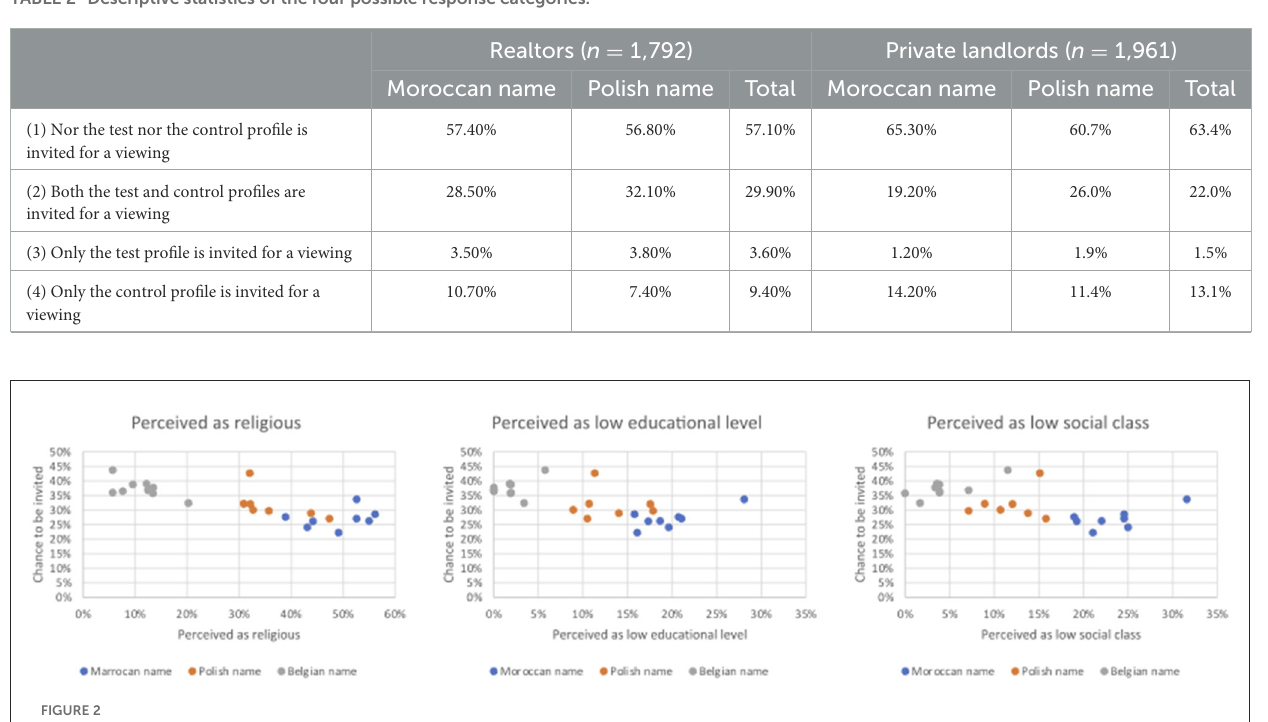
TABLE 2 Descriptive statistics of the four possible response categories.